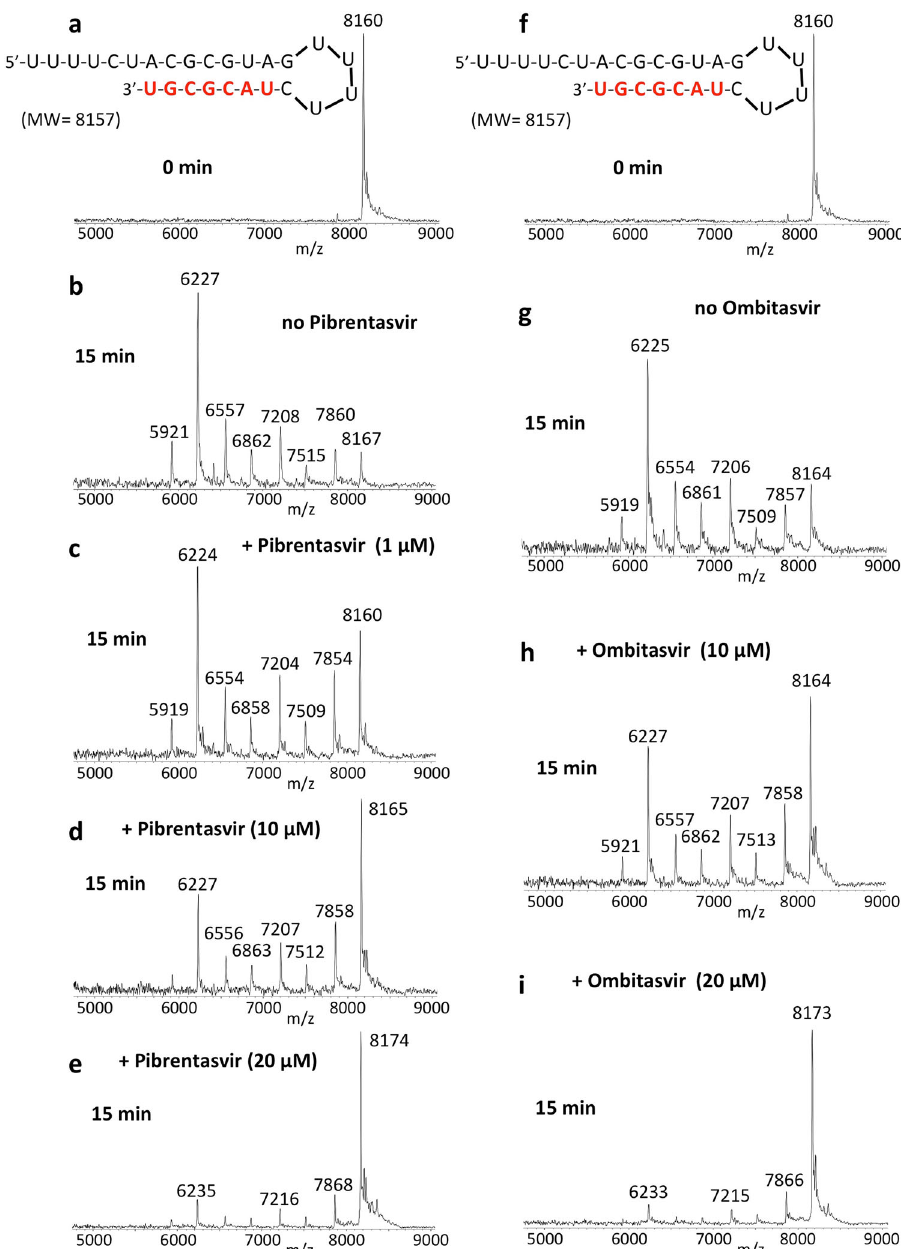
Fig. 3 Inhibition of SARS-CoV-2 exonuclease activity by Pibrentasvir and Ombitasvir. A mixture of 500 nM RNA (sequence shown at the top of the fi gure) and 50 nM SARS-CoV-2 pre-assembled exonuclease complex (nsp14/nsp10) was incubated in buffer solution at 37 °C for 15 min in the absence ( b , g ) and presence of varying amounts of Pibrentasvir ( c – e ) and Ombitasvir ( h , i ). The RNA ( a , f ) and the products of the exonuclease reaction ( b – e , g – i ) were analyzed by MALDI-TOF MS. The signal intensity was normalized to the highest peak. The peak at 8160 Da corresponds to the intact RNA (8157 Da expected). In the absence of Pibrentasvir, exonuclease activity caused nucleotide cleavage from the 3 ′ -end of the RNA as shown by the seven lower molecular weight fragments corresponding to cleavage of 1 – 7 nucleotides ( b ). Under our experimental conditions, ~7% intact RNA remained as indicated by the peak at 8167 Da ( b ). With increasing amounts of Pibrentasvir, exonuclease activity was reduced as shown by the reduced intensities of the fragmentation peaks and increased intact RNA peak ( c – e ). Similar results were observed with Ombitasvir ( f – i infection (MOI) of 0.1 and treated with the drugs under inves- CoV-2 potencies of the HCV NS5A inhibitors were ~10 times tigation alone or in combination. After 2 – 3 days, culture super- tasvir) compared to other repurposed RdRp inhibitors, such as natant was harvested and titered in Vero E6 cells to quantify the infectious viruses as plaque-forming units (PFU). The NS5A (Supplementary Table S-1). inhibitors Pibrentasvir, Ombitasvir, and Daclatasvir inhibited To produce clinical bene fi t, inhibition of SARS-CoV-2 exonu- SARS-CoV-2 replication in a dose-dependent manner (Supple- clease by NS5A inhibitors need to enhance the anti-coronavirus mentary Fig. S-8), but with lower potencies than Remdesivir activity of RdRp inhibitors by orders of magnitude. Thus, Sofosbuvir (RDV) (Supplementary Table S-1). Nevertheless, anti-SARS-